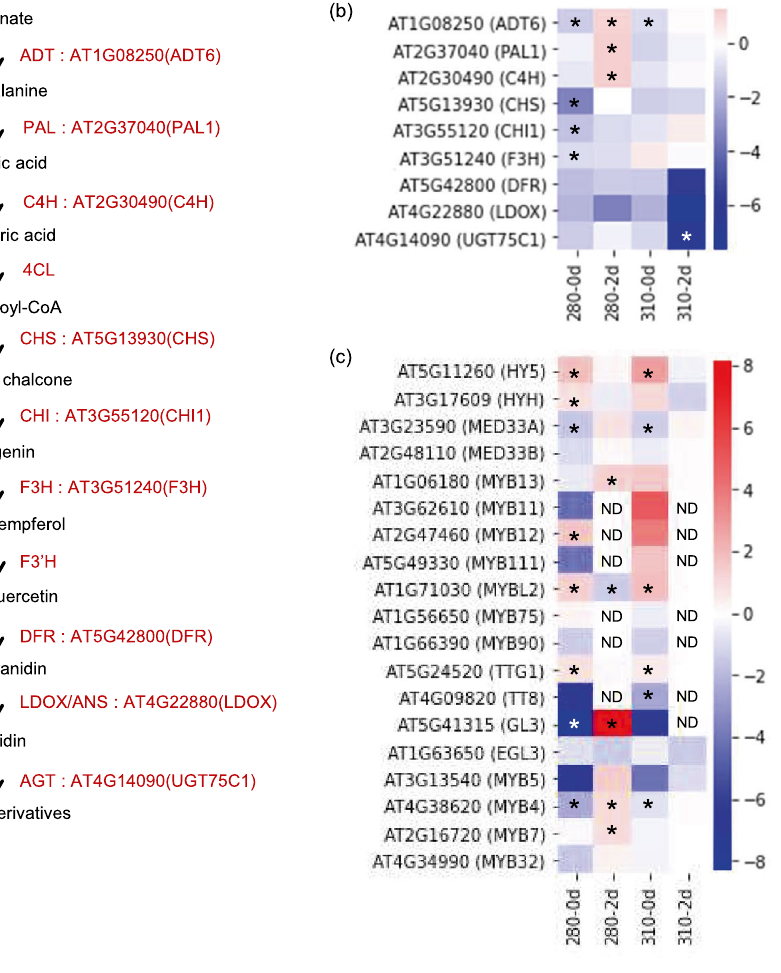
Figure 7. Gene expression profiles of enzymes and transcription factors involved in flavonoid biosynthesis under 280 and 310 nm UV-LEDs. ( a ) Metabolic map of flavonoid GABA biosynthesis. ( b ) Heat map showing the expression level of enzymatic genes in flavonoid biosynthesis. ( c ) Heat map showing the expression level of transcription factors in flavonoid biosynthesis. Changes in gene expression levels relative to the control are expressed as log 2 (fold change) values. As shown on the color scale, blue indicates down-regulation and red indicates up-regulation. Asterisks indicate significant differences between the control and UV-LED irradiation using Welch’s t -test (* P < 0.05). ND, not